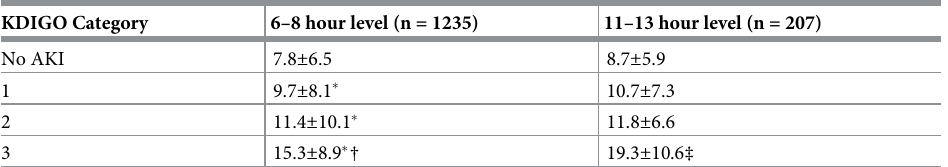
Table 3. Serum concentrations of vancomycin at differing time